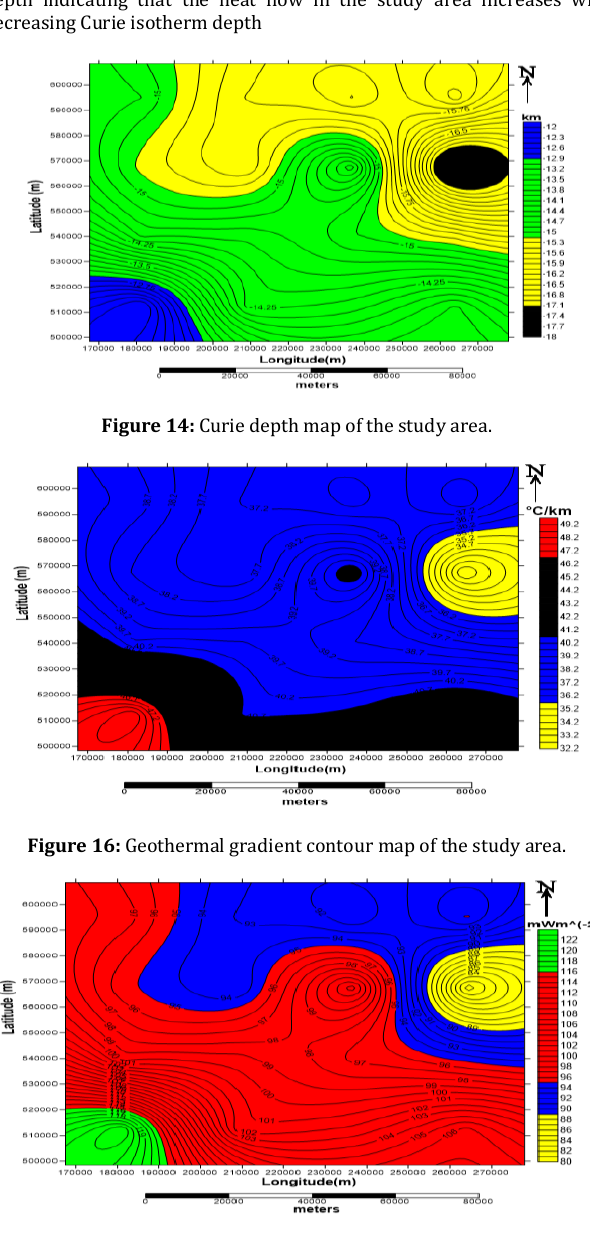
Figure 17: Heat flow contour map of the study area.